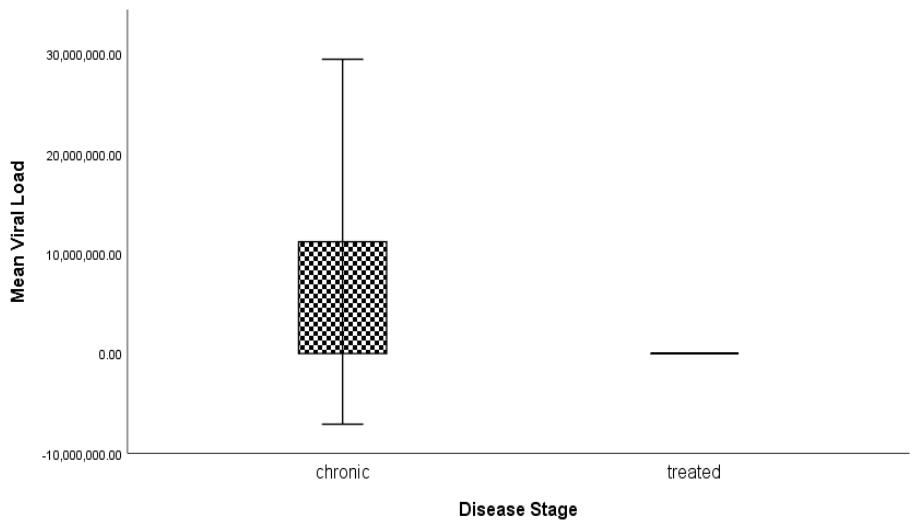
Table 5. Association of age and biochemical parameters considering the chronic and treated groups.